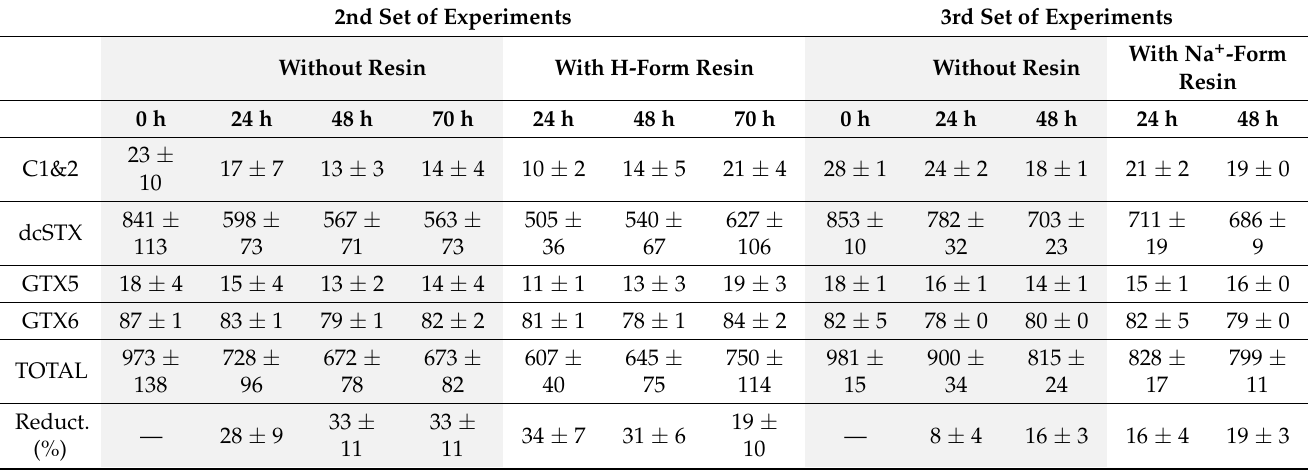
Figure 8. PST clearance results (global values) from live bivalves using H-form resin ( left ) and Na + - form resin ( right ). Natural clearance (without resin) is also presented for each set of experiments. Table 2. PST concentrations, in µ g STX.2HCl eqv/Kg (average ± SD), in mussels Mytilus edulis obtained from in vivo studies, in the absence of resin or in the presence of the H-form (2nd set) and Na + -form (3rd set) resins. At time 0 (day 6 of each experiment), no resin was present. 2nd Set of